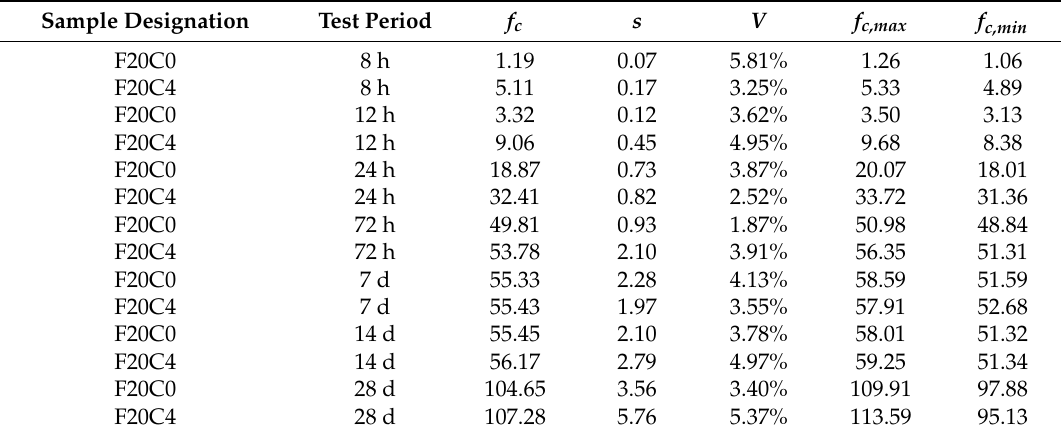
Table 5. Detailed results for the compressive strength test.